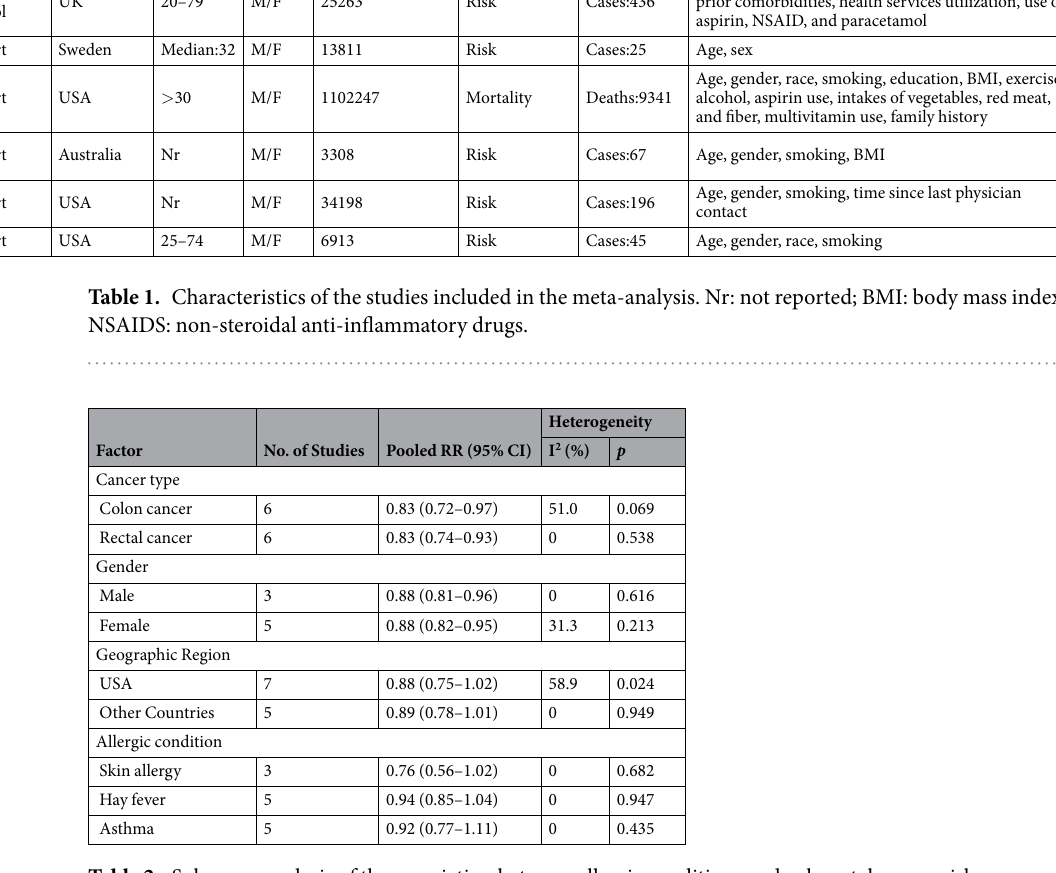
Table 2. Subgroup analysis of the association between allergic conditions and colorectal cancer